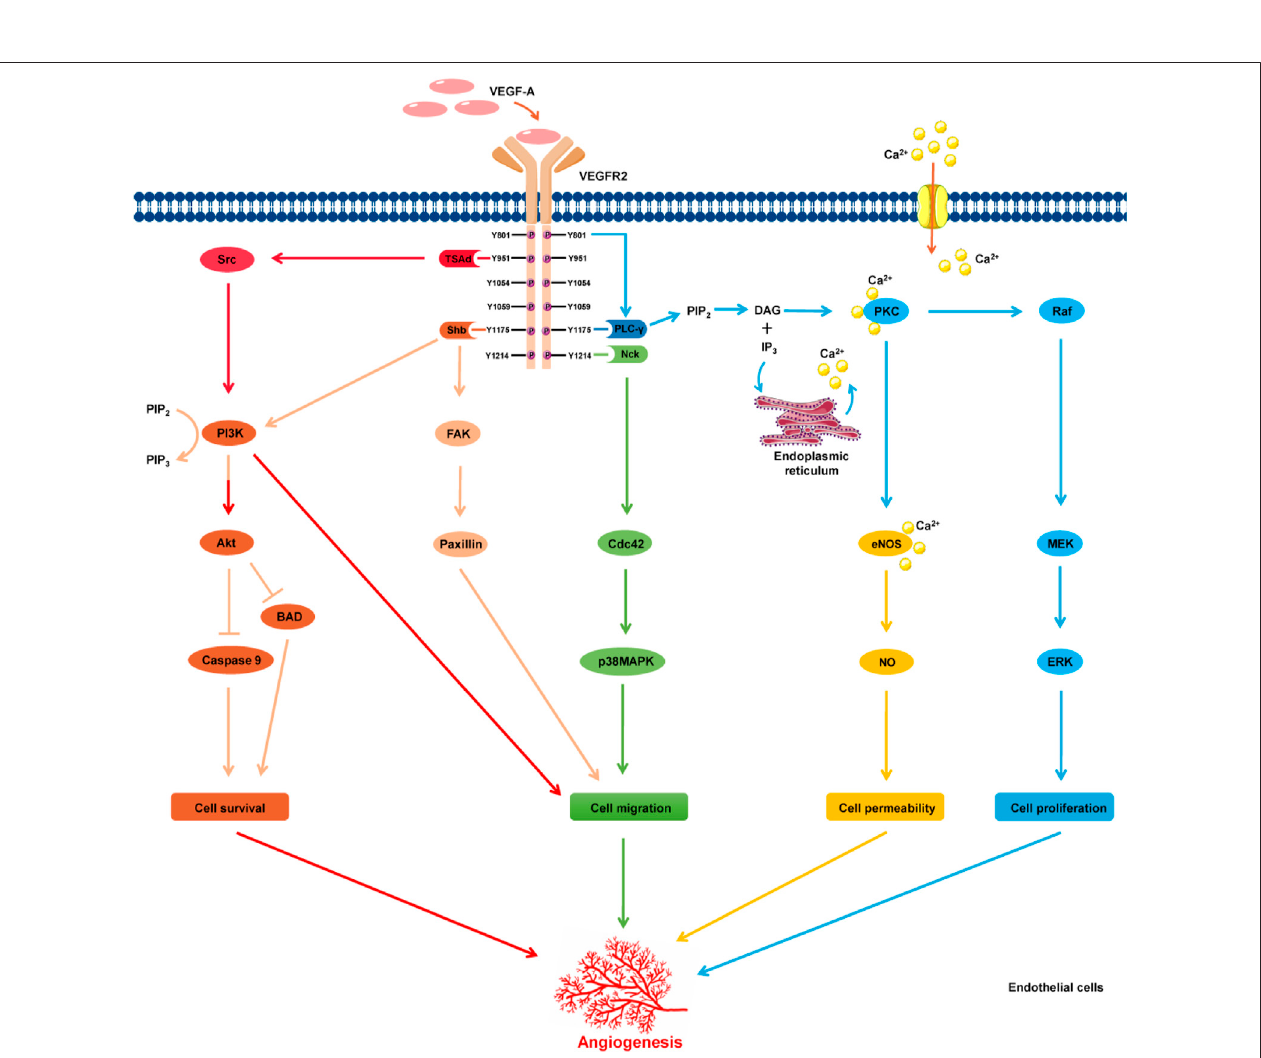
FIGURE 1 | Schematic illustration of VEGFR-2 signaling pathways. Stimulation of VEGFR-2 by VEGF-A induces dimerization and autophosphorylation of speci fi c intracellular tyrosine residues. Subsequently, the activation of the downstream signal transduction pathways induces the proliferation, migration, and survival of endothelial cells, and increases vascular